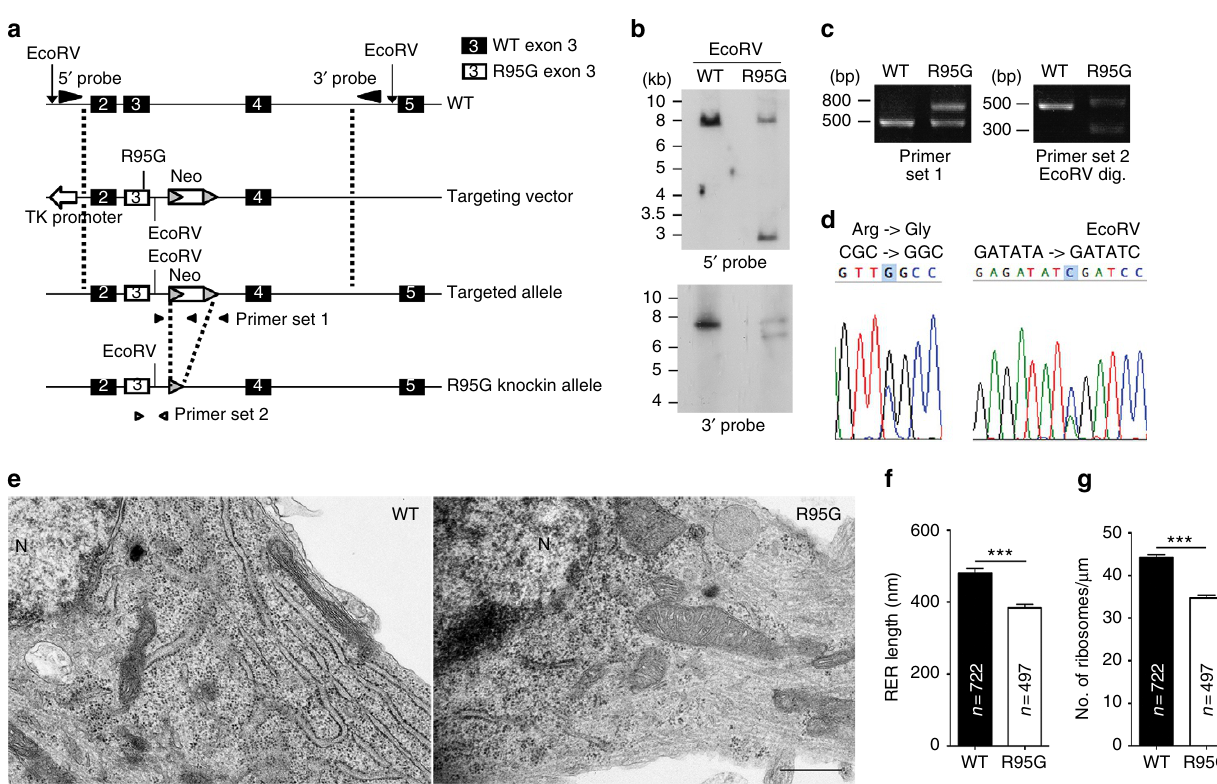
Figure 4 | VCP R95G knockin mutant neurons have altered rough ER in somata. ( a ) Schematic of mouse Vcp genomic organization and design of the R95G knockin-targeting construct. Dark box and open box indicates WT and Vcp R95G (R95G) mutated exons, respectively. ( b ) Genomic Southern blotting analysis with the 5 0 probe: 7.1kb for WTand additional 2.7kb for Vcp wt/R95G (R95G) mice; 3 0 probe: 7.1kb for WTand additional 6.2kb for R95G mice. ( c ) Genotyping by PCR with primer set 1: products of 475bp for WTand additional 711bp for R95G mice; primer set 2: products of 497bp for WTand 500bp for R95G allele. The R95G PCR product was digested with EcoRV to generate 236 and 264bp fragments. In ( b , c ), images have been cropped for presentation. Full-size images are presented in Supplementary Fig. 9. ( d ) Sequencing results of the PCR product amplified by primer set 2 to reveal R95G and EcoRV mutations. ( e ) TEM analysis of cultured hippocampal neurons from WTand R95G mice at 18 DIV. Neurons were collected from nine mice for each group from three independent experiments. Number of analyzed neurons: WT, 120; R95G, 132. Error bars present the mean þ s.e.m.. N, nucleus. ( f , g ) The length and ribosomal density of rER were quantified. Scale bar: 500nm. *** P o 0.001; unpaired t